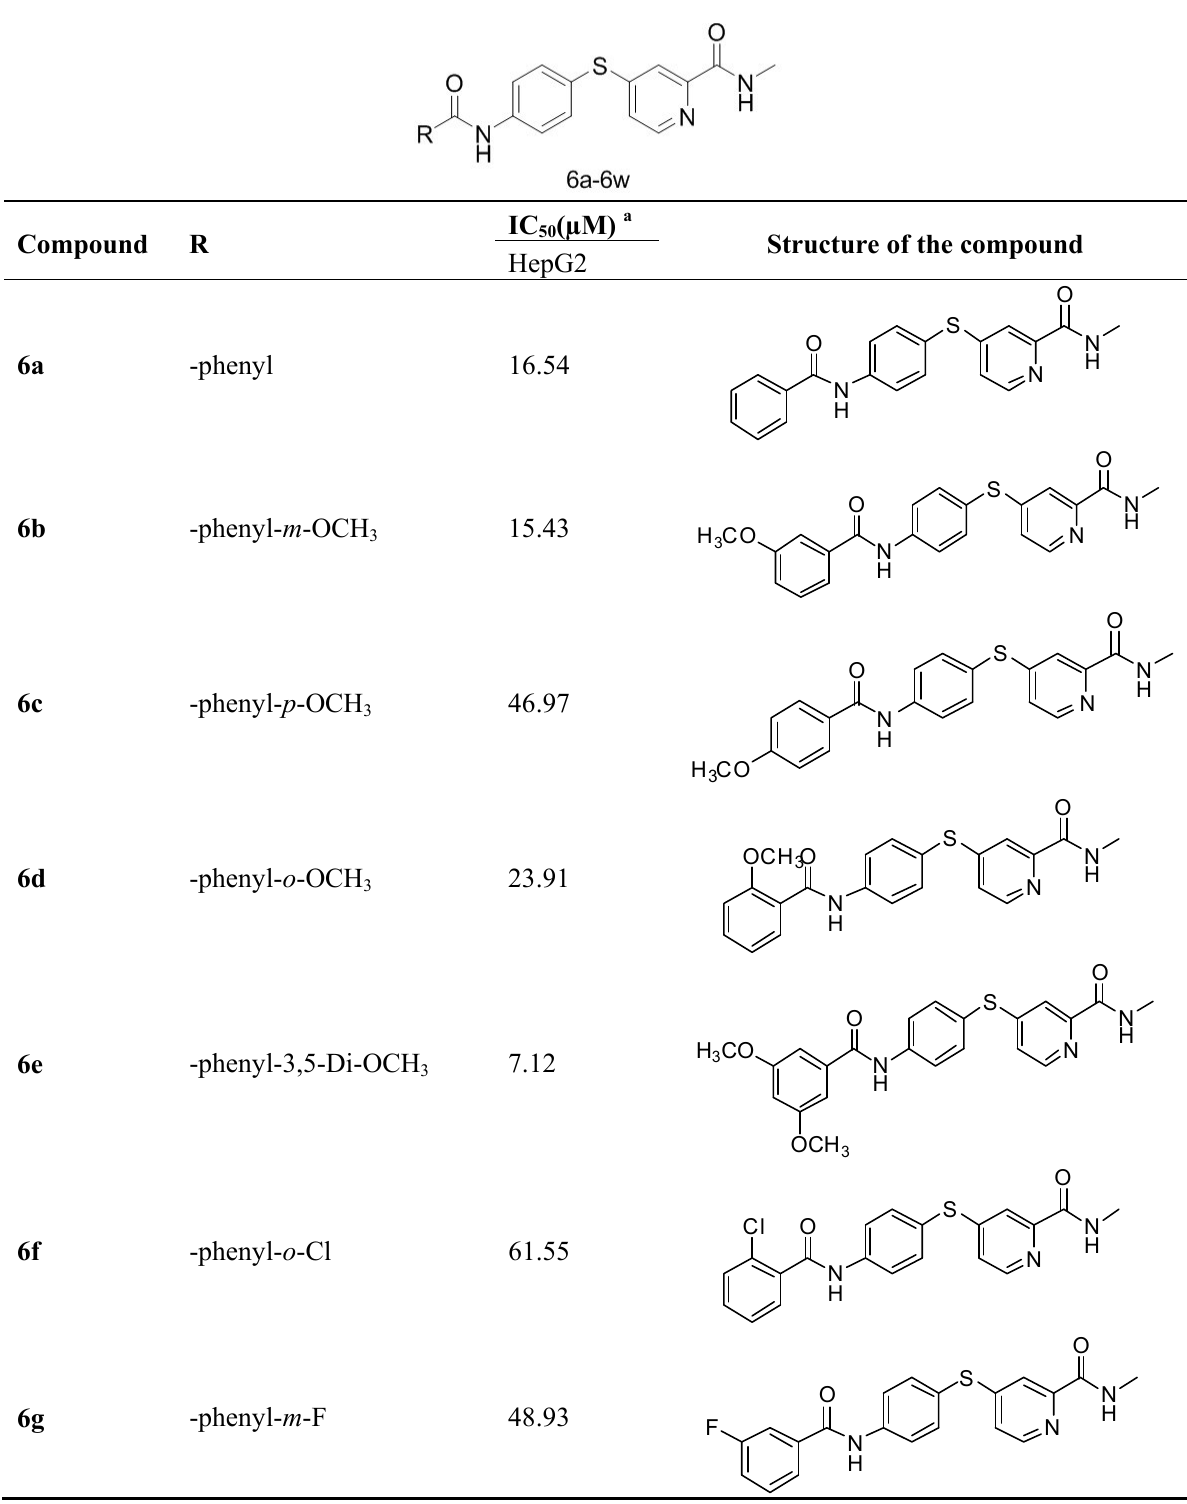
Table 1. Inhibition of cell proliferation by compounds 6a–w